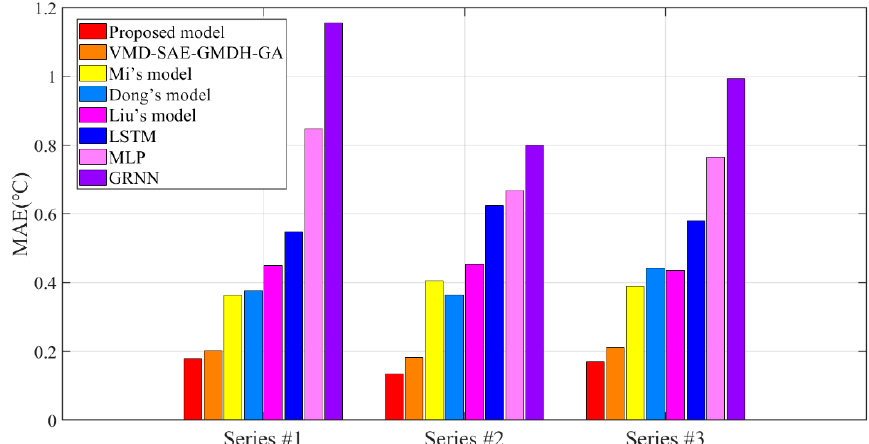
enlargement. distribution; ( c ) local